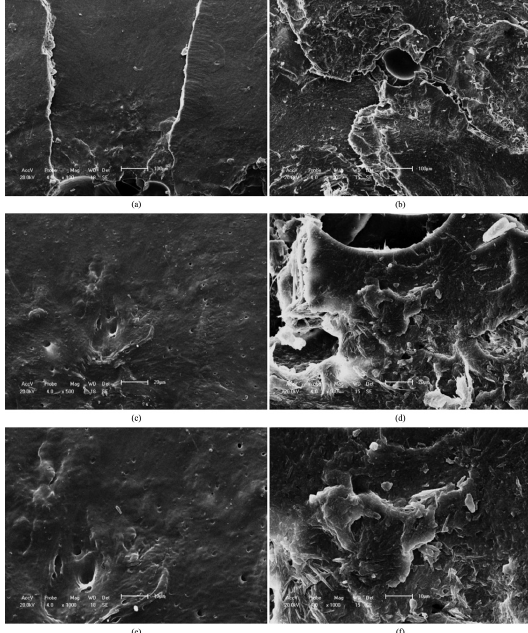
Figure 12. Scanning electron microscopy of fractured surface of PHB-1 bars, during stress versus strain tests at 0.1 mm/min. Images (a), (c), (e) of unexposed bars, images (b), (d), (f) of bars exposed to NaOH. Images (a) and (b): low magnification; images (c) and (d): intermediate magnification; images (e) and (f): high magnification.